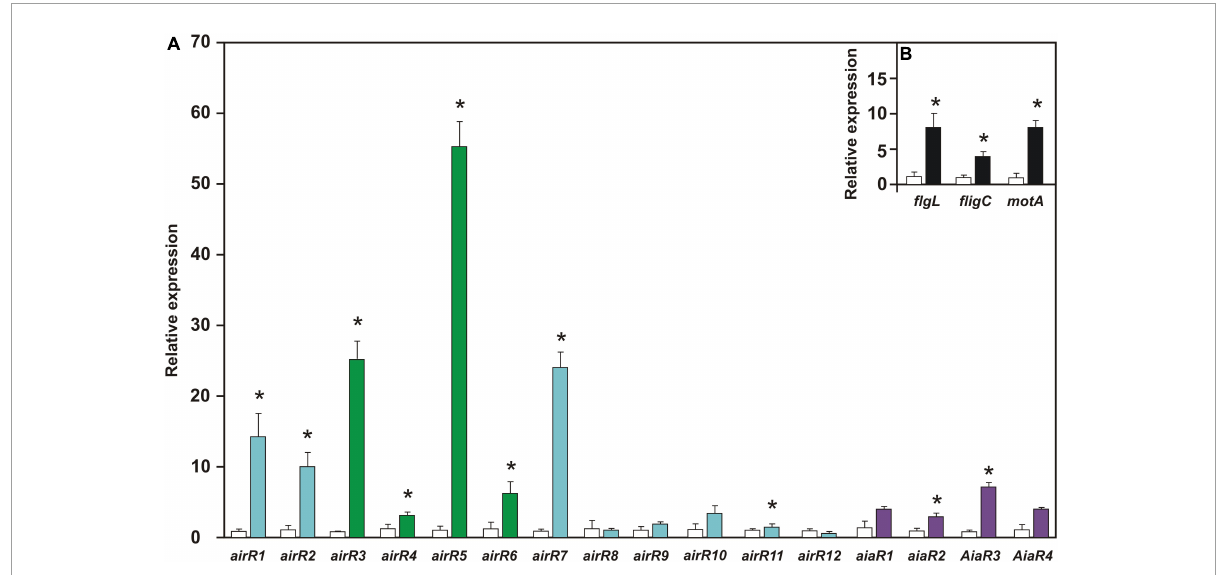
FIGURE6 The relative expression of auto-inducer-related regulators ( airR ), auto-inducer analog regulator ( aiaR ), and motility-involved genes in Arthrobacter sp. UMCV2 induced with DMHDA. Arthrobacter sp. UMCV2 was induced with dimethylhexadecylamine (DMHDA). After 72 h, relative expression of airR , aiaR genes panel (A) , and motility-involved genes panel (B) were determined. Values represent mean ± standard errors of relative expression of three biological replicates in reference to control (with bars). Asterisks indicate significant differences between treatments calculated using Student’s t -test ( p < 0.05). Genes belonging to Cluster I, II, and III of Figure 4 are colored in light blue, purple, and green,